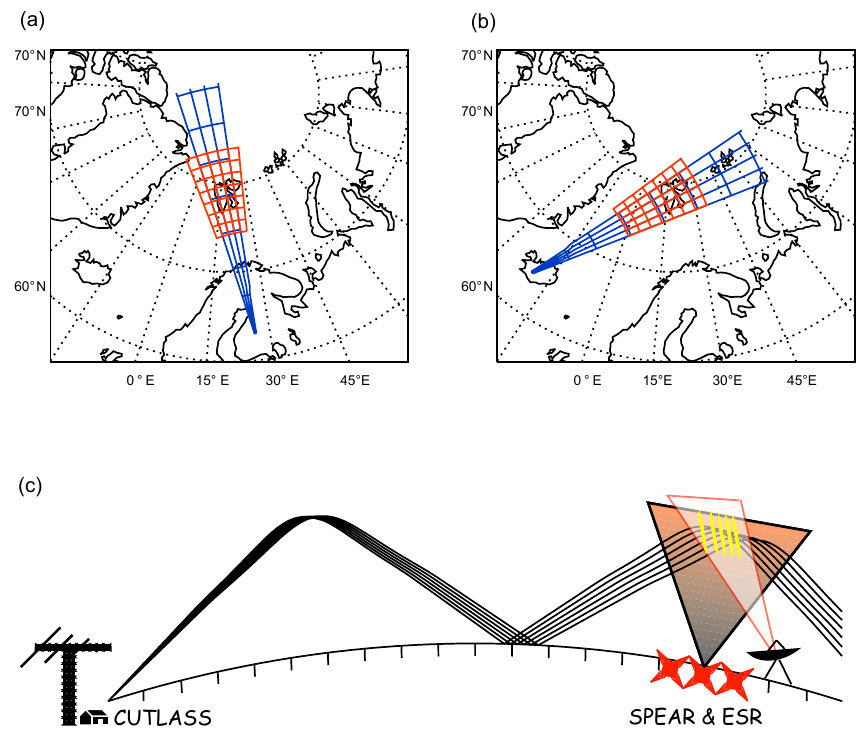
Fig. 5. Summary of CUTLASS experimental operations. (a) Scanning pattern for CUTLASS Finland, (b) scanning pattern for CUTLASS Iceland, (c) schematic of 1.5-hop propagation path between CUTLASS radar and SPEAR/ESR